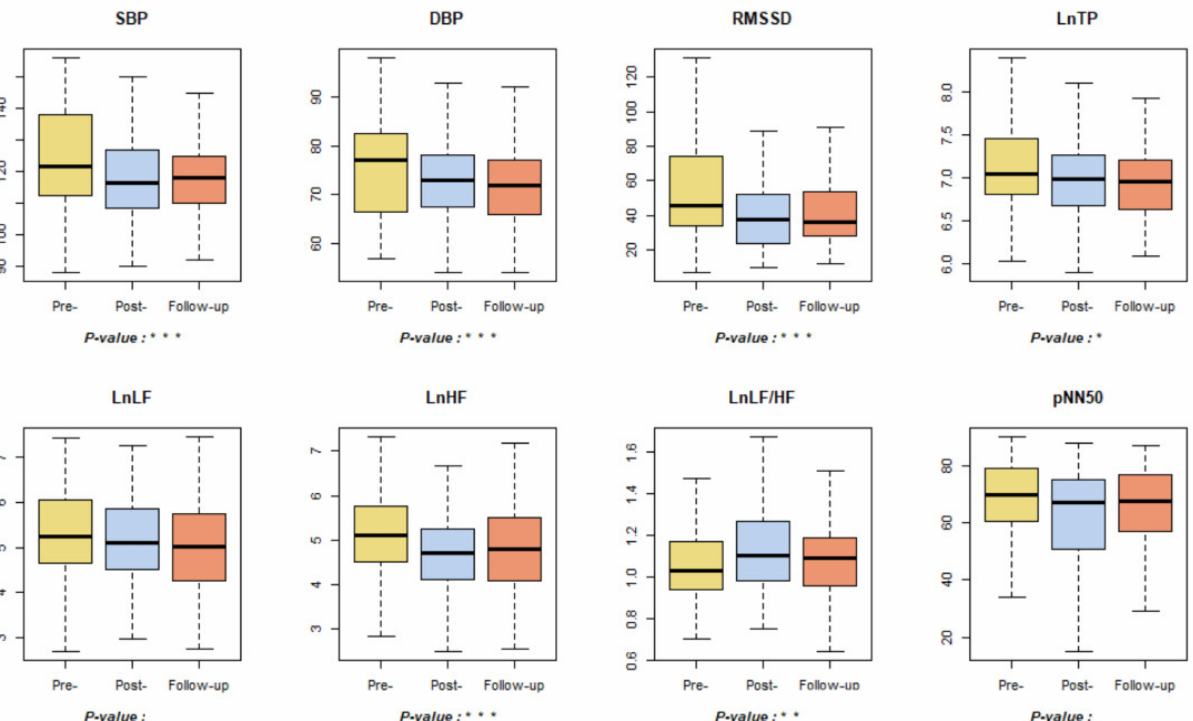
Figure 4. Results of blood pressure and autonomic nervous system related indicators. * p < 0.05, ** p < 0.01, *** p < 0.001. Pre-: daily health conditions two weeks prior to the forest healing program; Post-: health conditions immediately after the forest healing program; Follow-up: daily health conditions one, two, and four weeks after the forest healing program; SBP: systolic blood pressure; DBP: diastolic blood pressure; RMSSD: root mean square of successive RR intervals (interbeat intervals between all successive heartbeats) differences; Ln: natural logarithm (the spectral power data were log transformed); TP: total power; LF: power in the low frequency range; HF: power in the high frequency range; pNN50: percentage of successive RR intervals that differ by more than 50